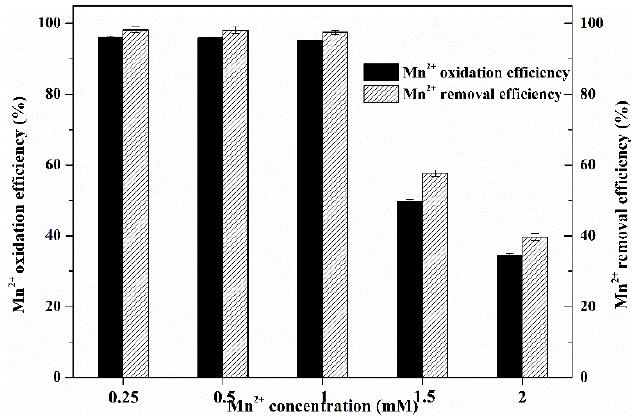
Figure 3. Mn 2+ oxidation and removal efficiency by mixed MnOMs after 10 days of culturing.